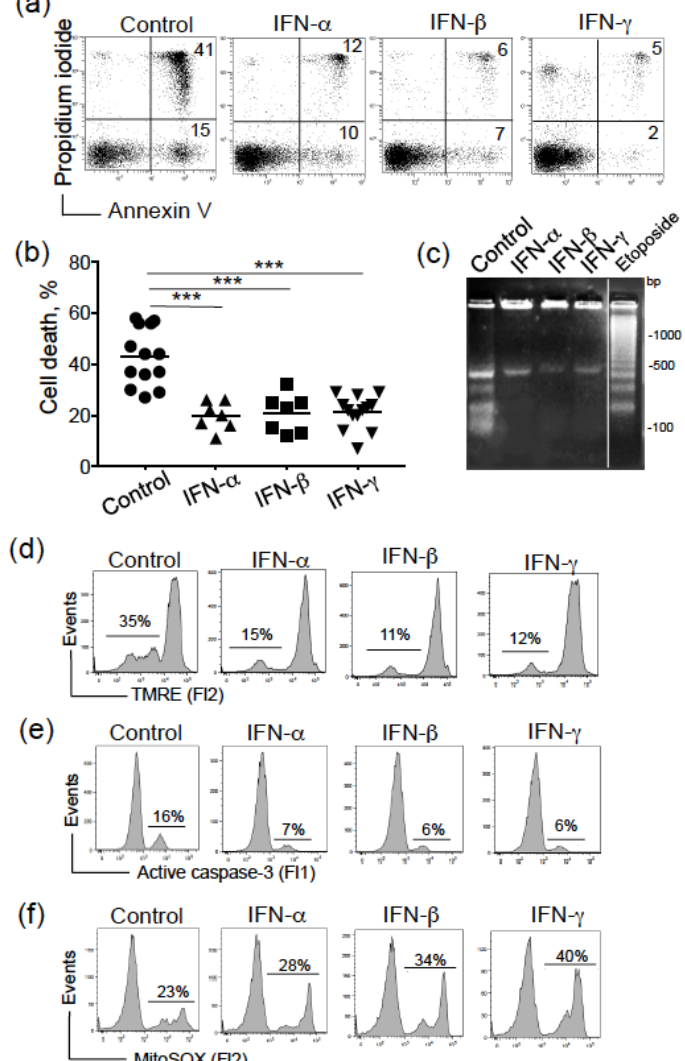
Figure 1. Type I and II IFNs induce resistance to apoptosis in CLL cells. ( a ) Representative cytograms of CLL cells cultured for 24 h in the presence or absence of IFN- α , - β , - γ (1000 U/mL); detection of apoptotic cells after annexin-V-FITC/PI staining and flow cytometry. The percentage of annexin-V-positive cells is shown. ( b ) The data of cell death are presented as mean ± SEM (13 controls, 7 treated IFN- α and - β , 13 treated IFN- γ ). P values were calculated using the unpaired t -test. *** p < 0.001. ( c ) CLL cells were cultured for 24 h in the presence or absence of IFNs, then DNA fragmentation was evaluated by the detection of an oligonucleosome ladder by agarose gel electrophoresis; etoposide treatment (10 µ M) was used as positive control of DNA fragmentation ( d – f ) CLL cells were cultured for 24 h in the presence or absence of IFNs (1000 U/mL, 24 h): ( d ) The ∆Ψ m was measured using the fluorescent probe TMRE, and analyzed by flow cytometry; the percentages refer to ∆Ψ m disruption. ( e ) Active caspase-3 expression was measured by flow cytometry; the percentages refer to the percentage of active caspase-3. ( f ) Mitochondrial ROS levels were recorded by flow cytometry with the use of MitoSOX. Percentages refer to cells with ROS